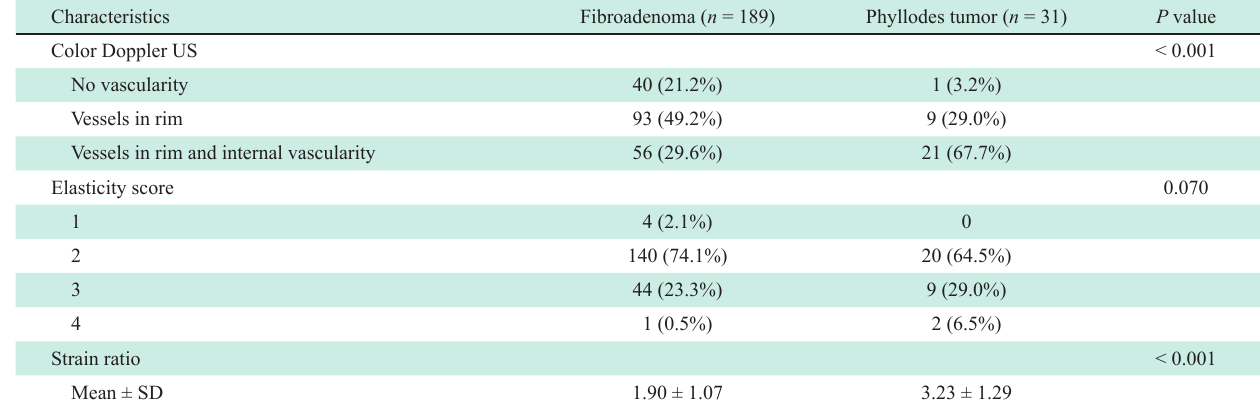
Table 2 Characteristics color Doppler US and strain elastography parameter of fibroadenomas versus phyllodes tumors